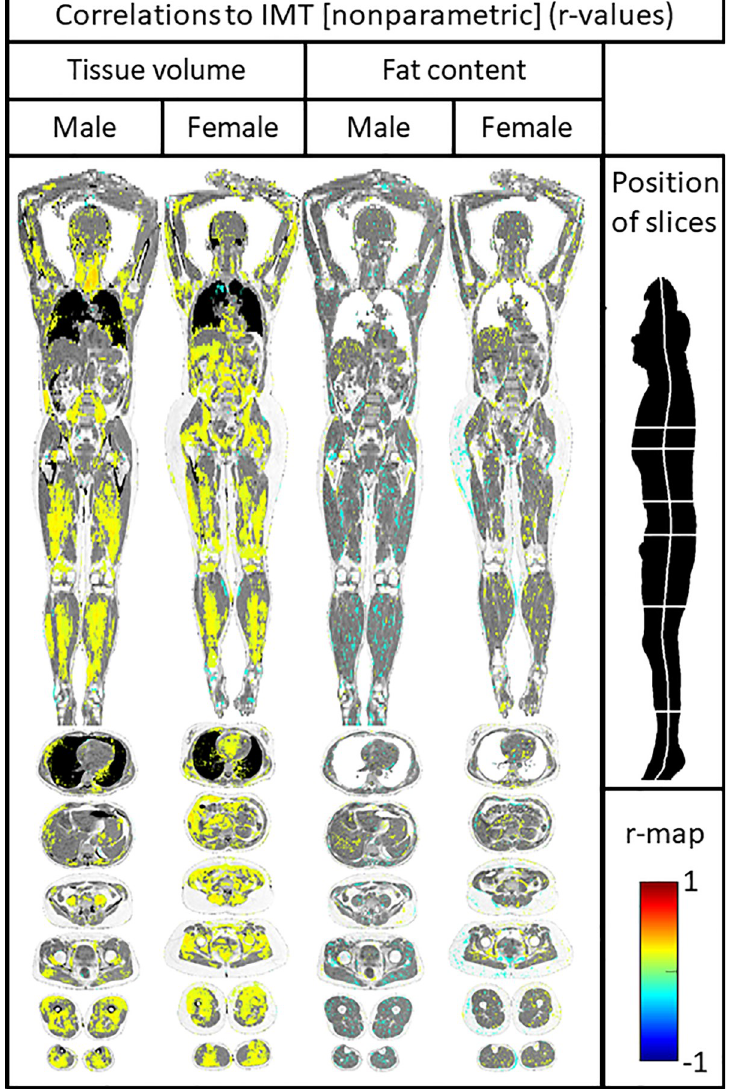
Fig 2. Imiomics correlation maps showing relations between tissue volume/fat content and carotid artery intima- media thickness (IMT). Significant (P < 0.05) voxelwise non-parametric Spearman rank coefficient correlation values are shown in the colorscale in the lower right. Pixels with non-significant correlations show the underlying water signal values. One Coronal slice and six axial slices are shown, as given by the illustration in the upper right part of the